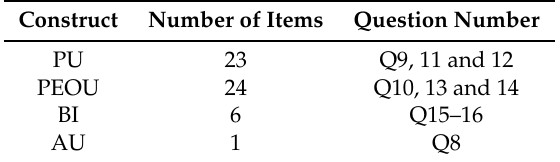
Table 2. Number of questions allocated for TAM constructs.